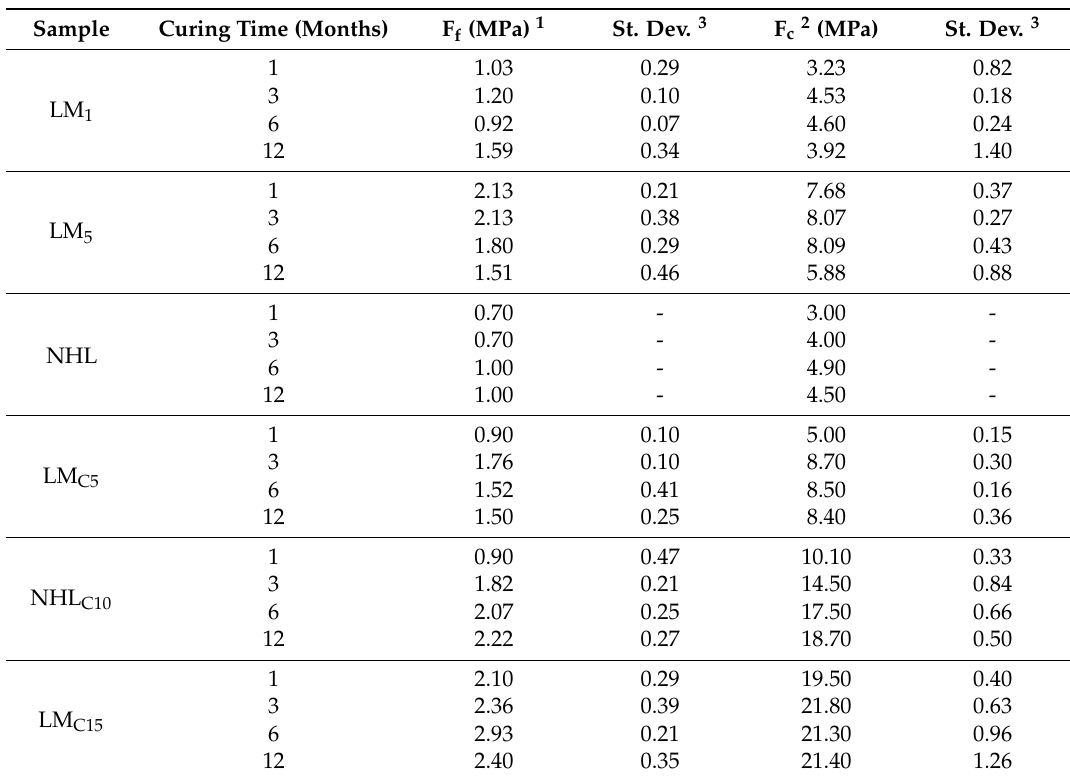
Table 7. Flexural and compressive strength values for examined mortar and concrete mixes [59,60].